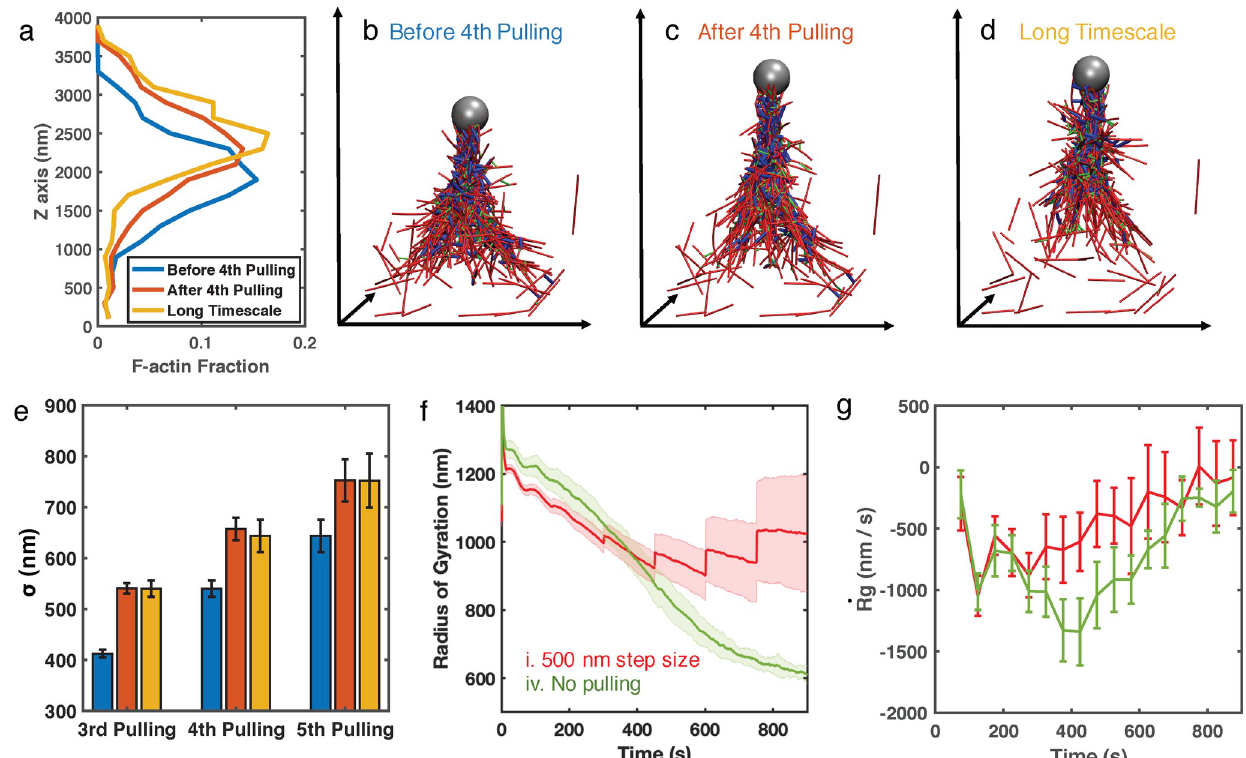
Fig 5. (a) F-actin distribution along the force direction (Z-axis) of the most representative trajectory before the 4 th pulling at t = 600 s (blue), after the 4 th pulling at t = 601 s (orange), and after the long-timescale chemical evolution at t = 750 s (yellow). (b-d) Corresponding simulation snapshots before pulling, after pulling, and after chemical evolution, respectively. (e) Standard deviations ( σ ) of the F-actin distribution along the force direction before pulling (blue), after pulling (orange), and after 150 s of chemical evolution (yellow) at the third, fourth, and fifth pulling events. σ are averaged over 10 duplicated trajectories, and error bars represent the standard errors. (f) The radius of gyration, Rg and (g) the rate of Rg change, _ R 500 nm pulling (red) and in Case iv without pulling (green). Shaded colors and error bars are the standard deviations of 10 duplicated trajectories for Case i and 5 duplicated trajectories for Case